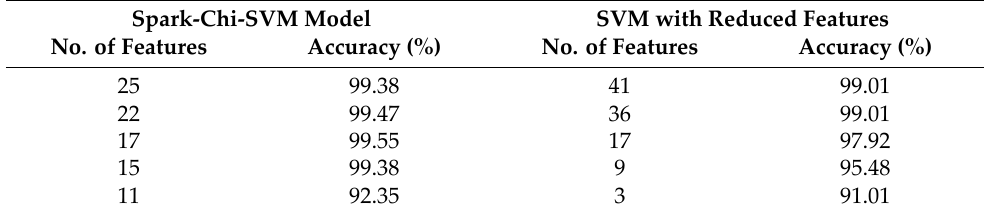
Table 10. Accuracy of the applied Features Selection